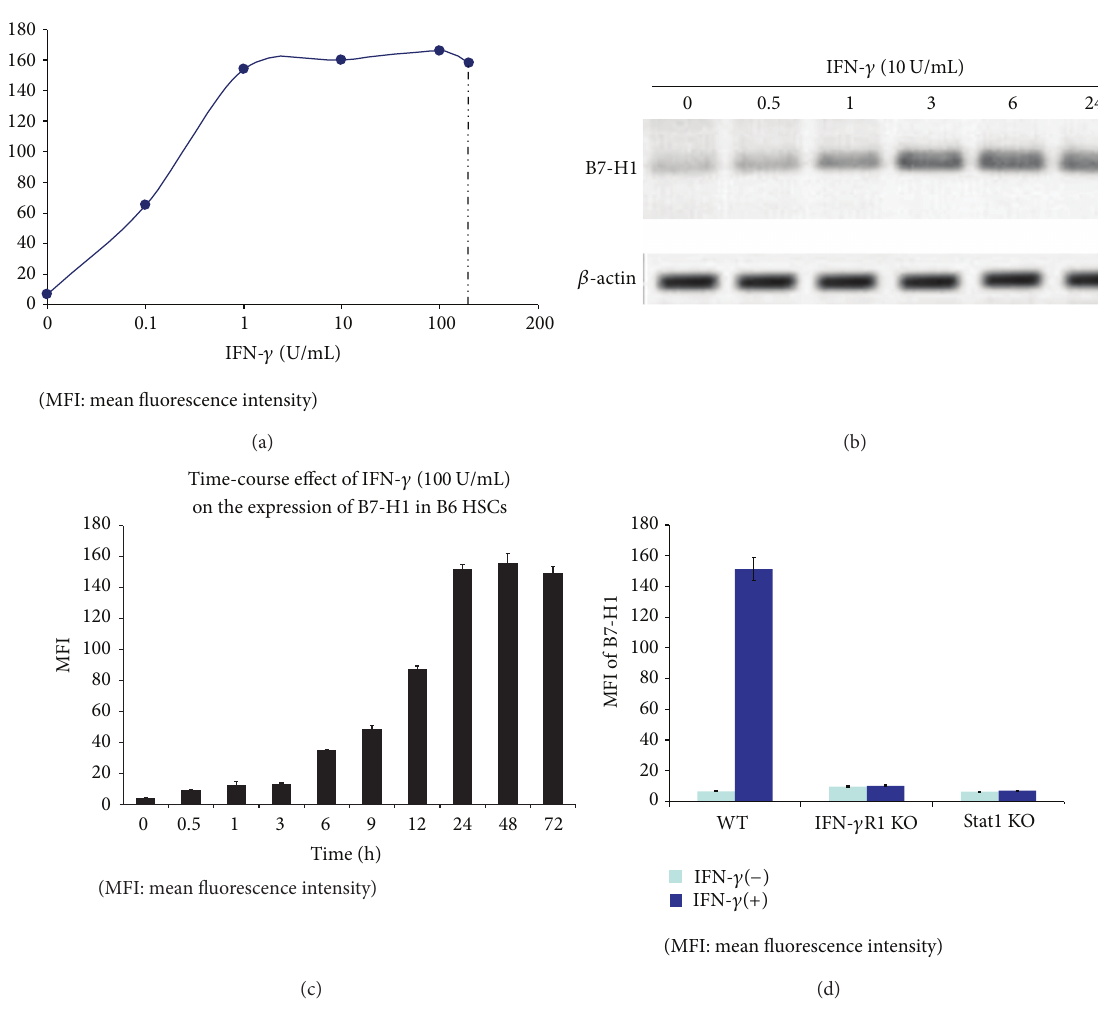
Figure 1: Expression of B7-H1 on HSCs in response to INF- 𝛾 stimulation. (a) HSCs isolated from B6 mice were exposed to graded concentrationsofIFN- 𝛾 (0.1–200 U/mL)for24hoursinvitroandstainedwithanti-B7-H1mAbandanalyzedbyflowcytometry.(b)HSCswere treated with IFN- 𝛾 (10U/mL) for varying times (0.5–24 hours) and analyzed by RT-PCR. (c) HSCs were incubated with IFN- 𝛾 (100U/mL) for the indicated times, and the expression patterns were analyzed by flow cytometry. (d) HSCs isolated from wild type (WT) or IFN- 𝛾 R1 KO mice or Stat1 KO mice (all on B6 background) were exposed to IFN- 𝛾 (100U/mL) for 48 hours. Cells were stained using anti-B7-H1 mAb and analyzed by flow cytometry. The data are representative of two separate